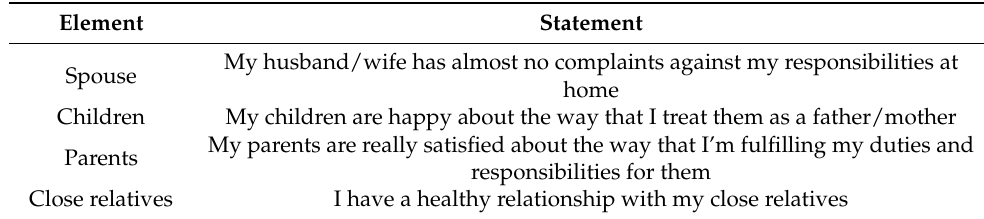
Table 2. The elements and statements of the dimension of “family member’s